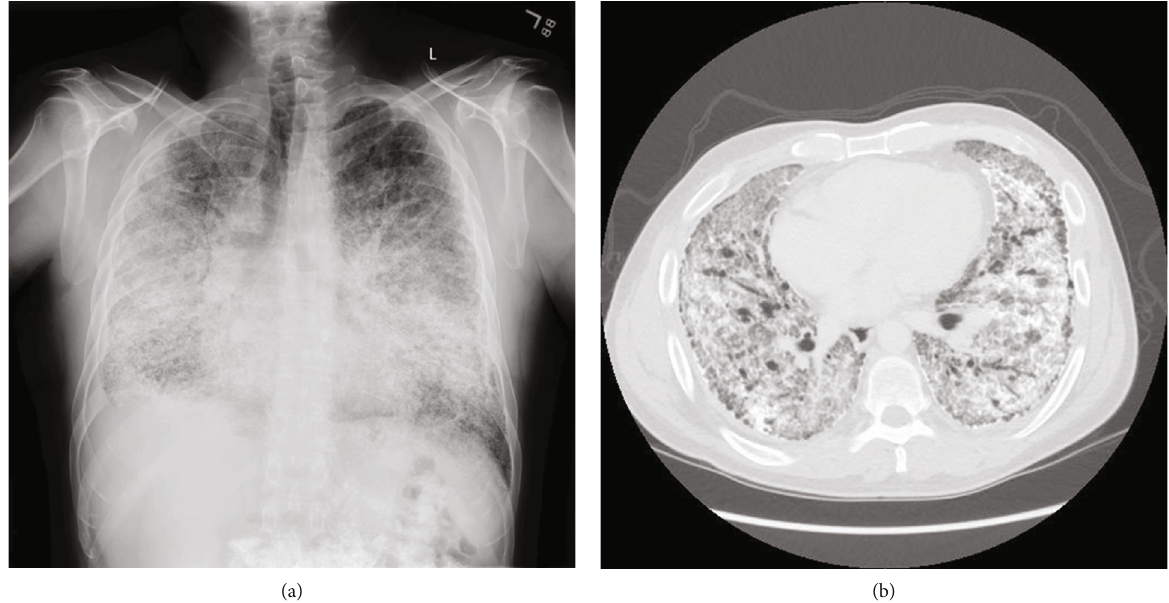
Figure 1: Radiologic fi ndings consistent with PAM. (a) Chest X-ray demonstrating di ff use bilateral interstitial hyperdensities with bibasilar predominance consistent with severe interstitial lung disease. (b) Transverse view of chest CT showing di ff use ground-glass opacities, peripheral cystic change, and di ff use areas of fi ne calci fi cation.